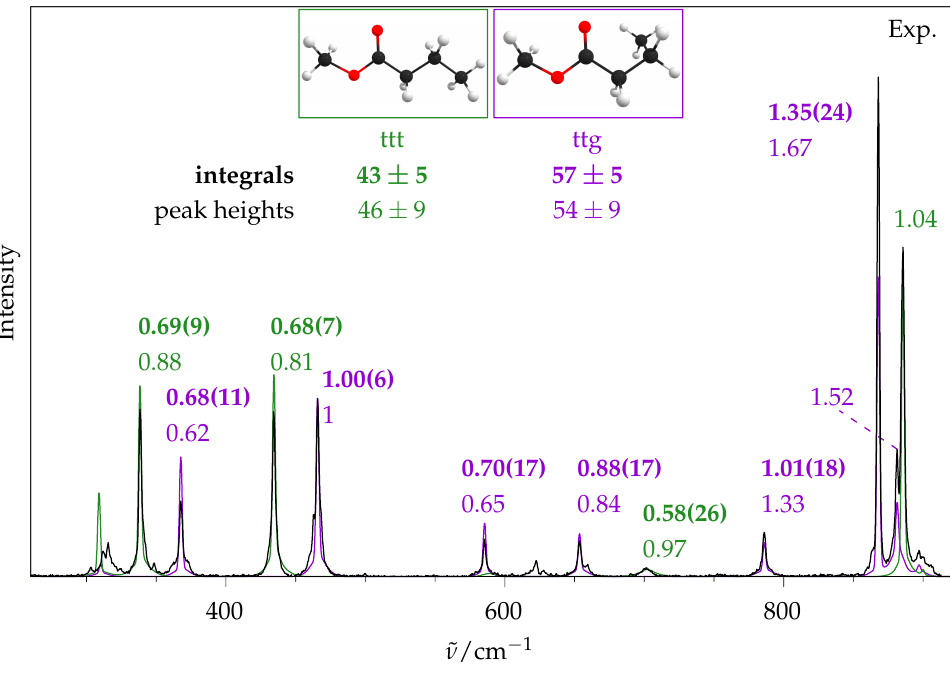
Figure 13. Determination of conformational ratio for methyl butanoate. Black trace: argon-enriched jet spectrum (Figure 11, trace (e)). Coloured traces: rovibrational simulations of ttt and ttg, using experimental wavenumbers (except for the signals around 300cm −1 , which are not included in the analysis anyway). Non-bold numbers without uncertainty: factors, by which the simulated peak height has to be multiplied to match the experiment. Bold numbers with uncertainty: Ratio of integrated signal intensity and calculated scattering cross sections. Normalised to the ttg signal at 466cm −1 .